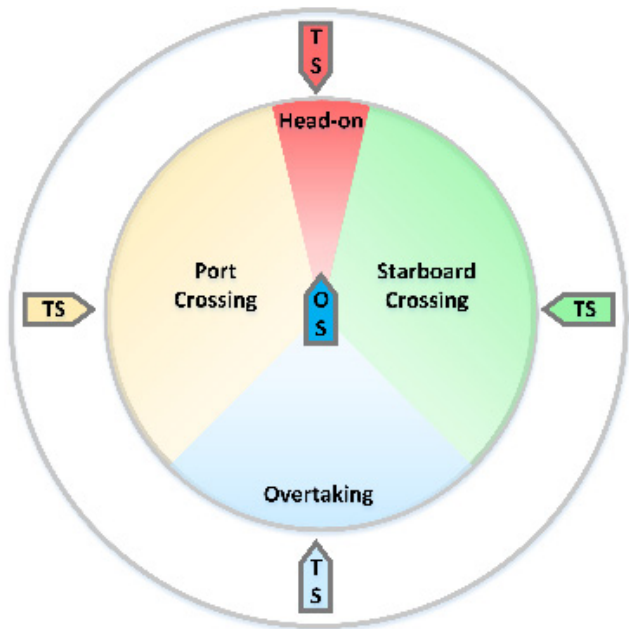
Figure 4. The categorization of TSs based on COLREGs. The collision avoidance behaviors conforming to COLREGs are shown in Figure